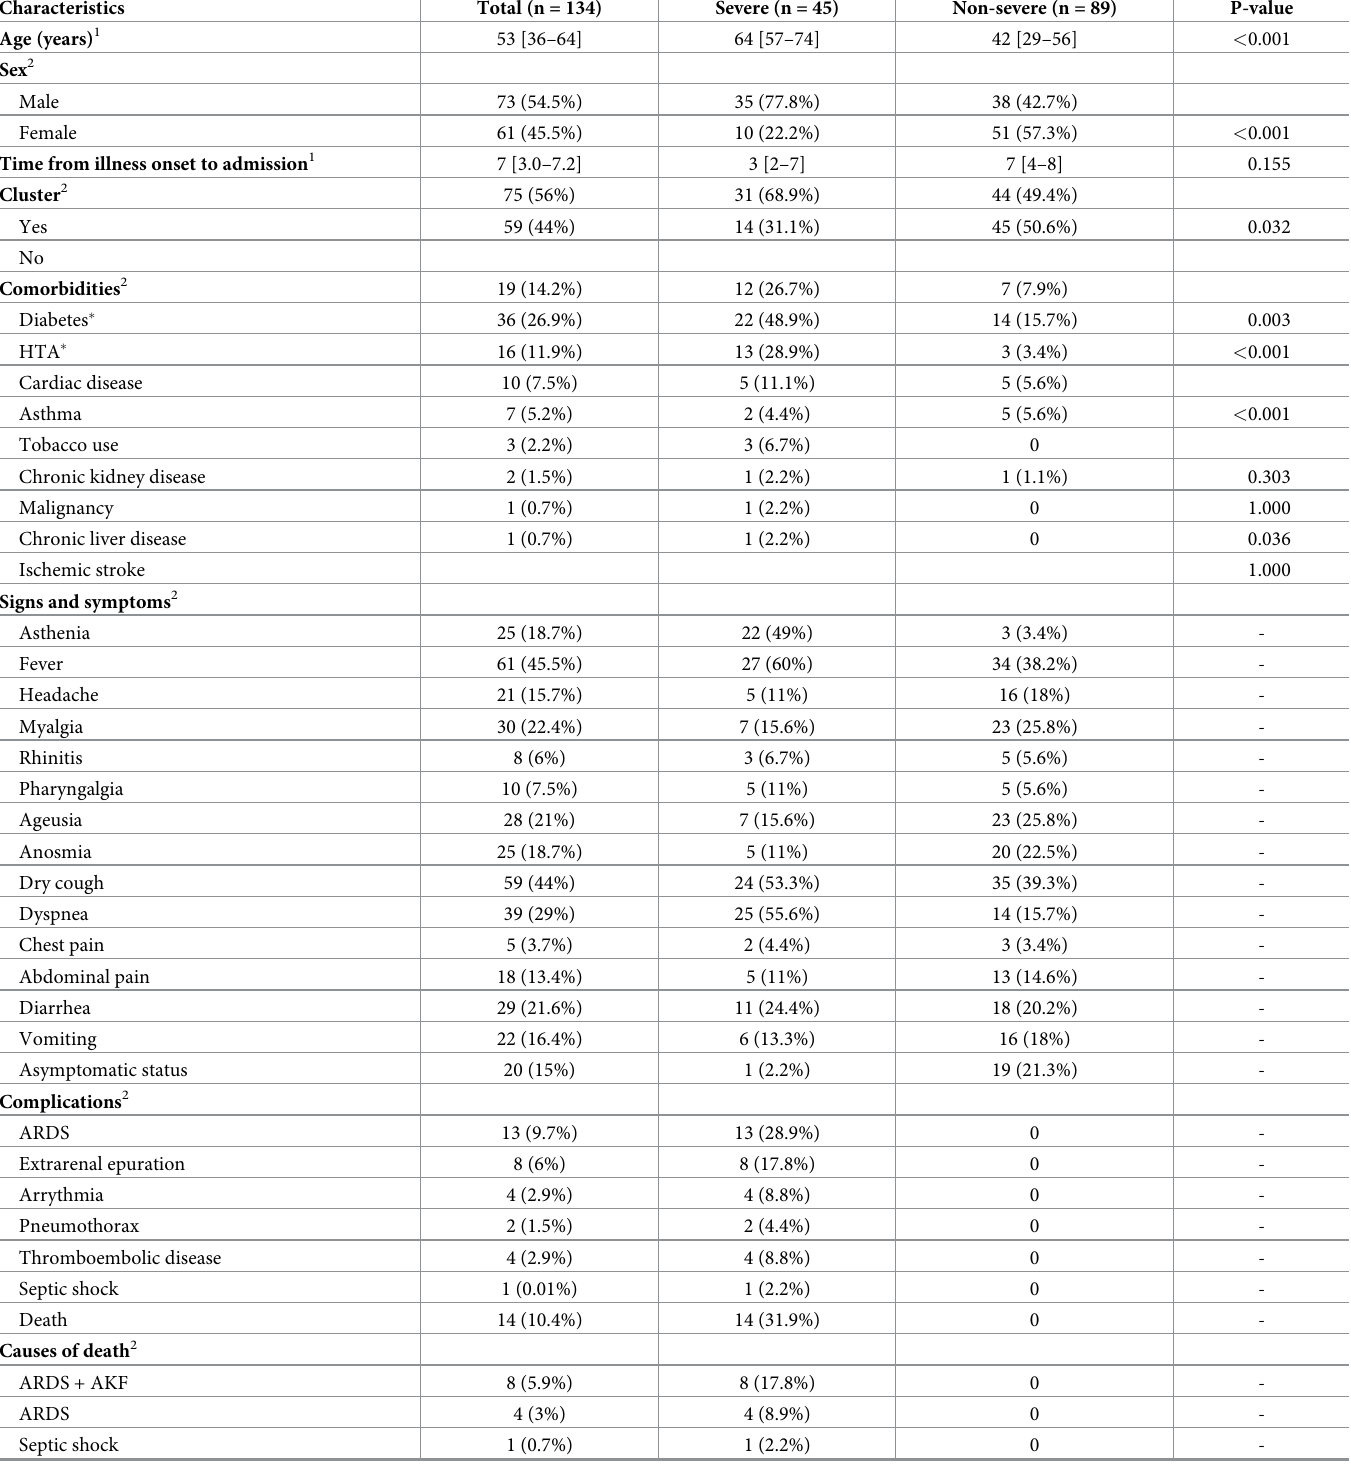
Table 1. Demographic and clinical characteristics of